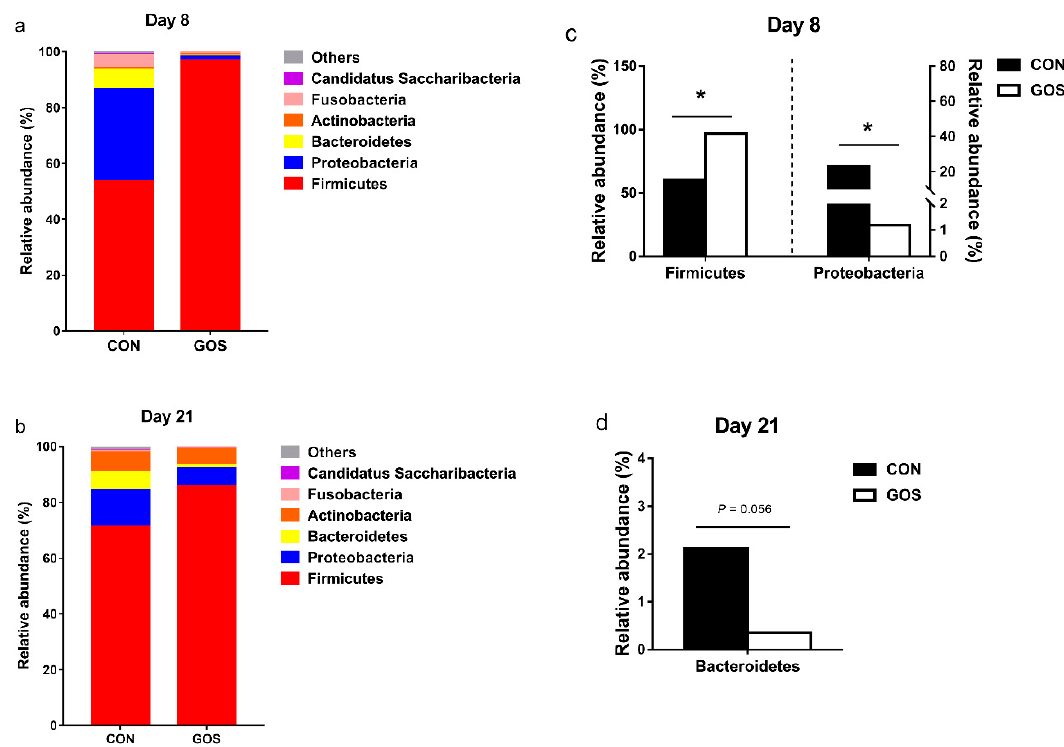
Figure 3. E ff ects of early-life galacto-oligosaccharides (GOS) intervention on the phylum-level composition. ( a , b ) The phylum-level composition of average relative abundance ileal microbiota in suckling piglets; ( c , d ) the changes in the abundance of bacterial phyla found in ileum. The values are expressed as the medians, with five piglets per group. The “ * ” indicates a significant di ff erence ( P < 0.05) between the CON and GOS group (Mann–Whitney U -test). CON, a control group; GOS, a galacto-oligosaccharides intervention group.